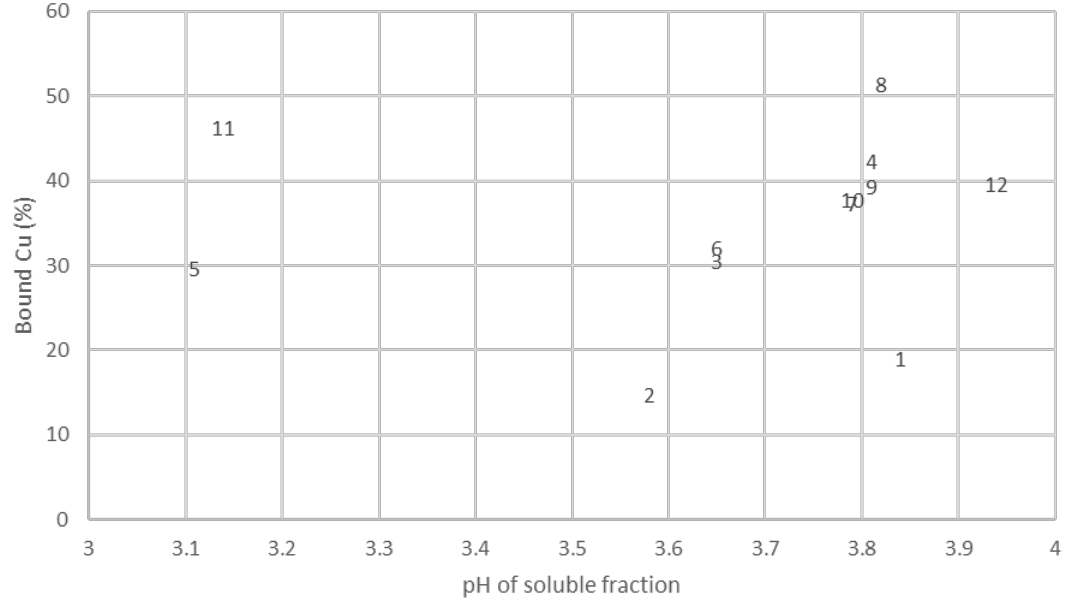
Figure 3. Scatter plot of initial pH and corresponding bound Cu (%) for mineral proteinates. 1–12 refer to the individual hydrolysates outlined in Table 1.